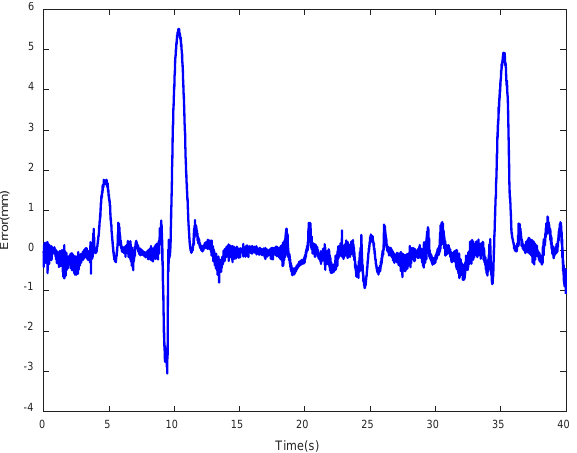
Figure 28. Error of the LSSVM ‐ NARX model at random sinusoidal actuating voltage II (RMSE = 0.9606).